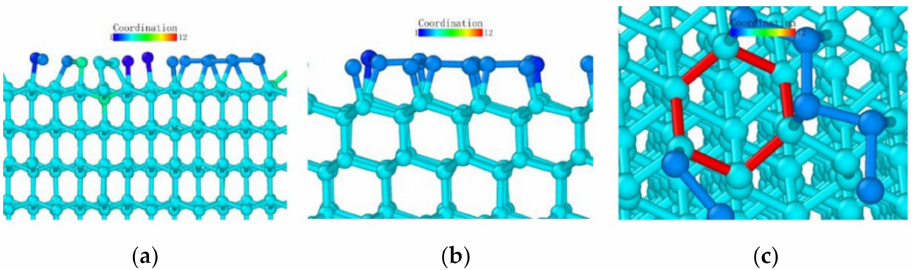
Figure 24. The (111) load model after relaxation. ( a ) side view, ( b ) enlarged side view, ( c ) marked hexagon.